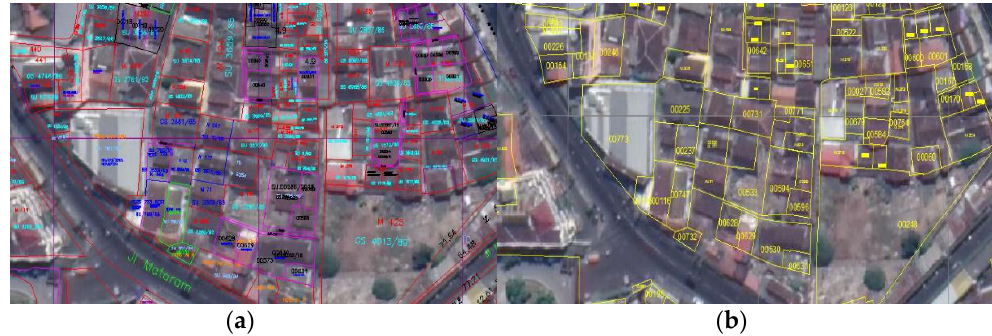
Figure 3. ( a ) Working map (the initial product of the mapping process); ( b ) GeoKKP parcel map (map of the final results of the plot mapping process, stored in the GeoKKP database on the central server).